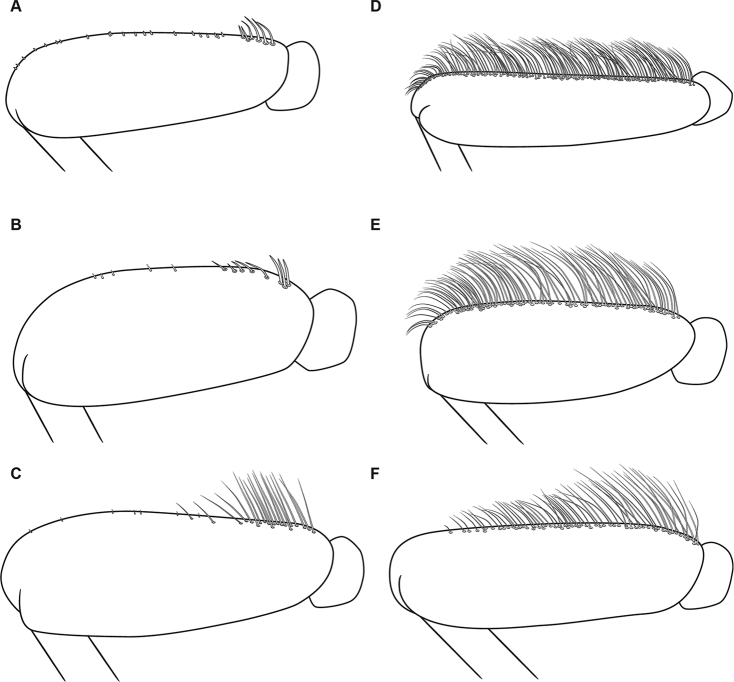
Hind femora of representative Oligoneuriella (A–C) and Oligoneuriopsis (D–F) species AOligoneuriella
rhenanaBOligoneuriella
pallidaCOligoneuriella
skouraDOligoneuriopsis
lawrenceiEOligoneuriopsis
skhounateFOligoneuriopsis
orontensis.